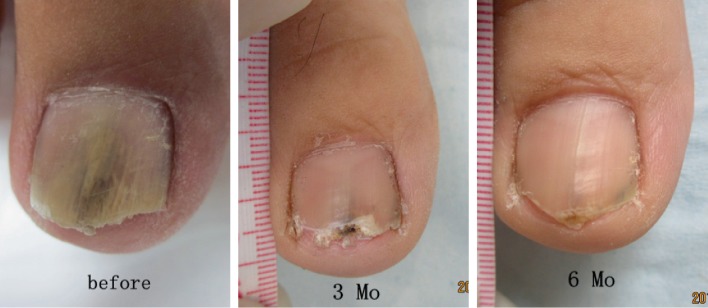
Images before and after eight treatment sessions for toenail onychomycosis.